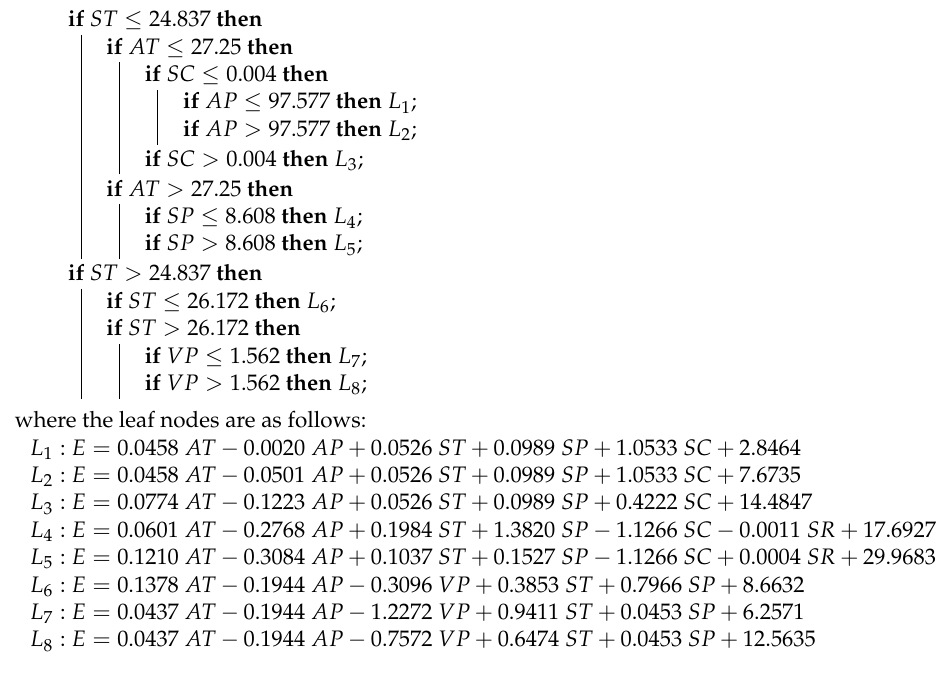
Figure 2. M5P regression tree to predict the value of the variable evaporation (E). For illustrative purposes, Figure 3 shows the behaviour of (Model A) DT in predicting the output variable E for the two used time periods. At the bottom of the figure is the residual error graph, showing for each observation the difference between the predicted value and the true value. As can be seen, the errors are minimal, and the obtained prediction is quite satisfactory.